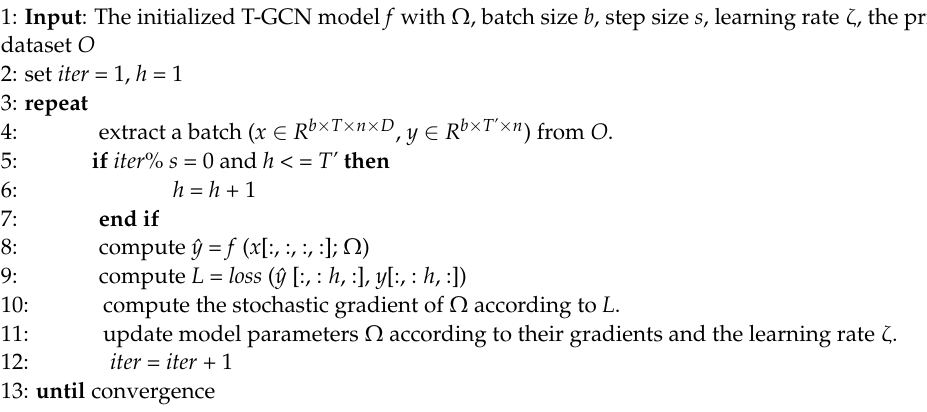
Algorithm 1 The training algorithm of T-GCN.